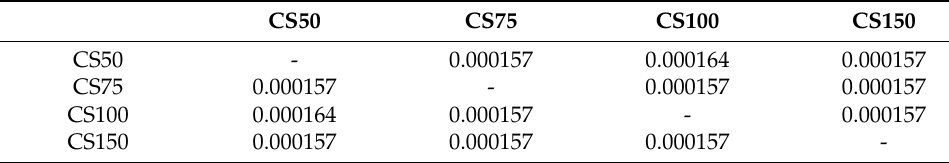
Table 4. Results of the Tukey’s post hoc test for the CS group of dies.